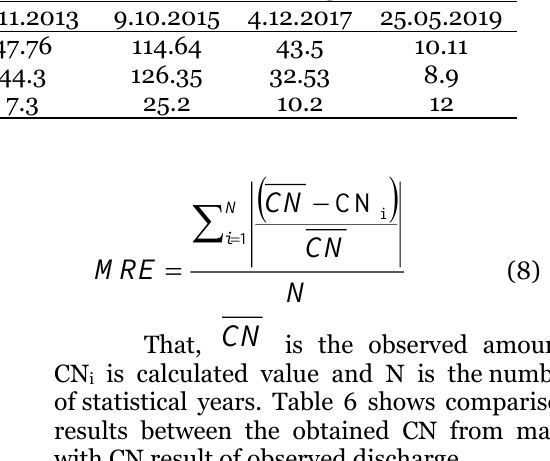
Table 5. Comparison of maximum simulated and observed discharge values